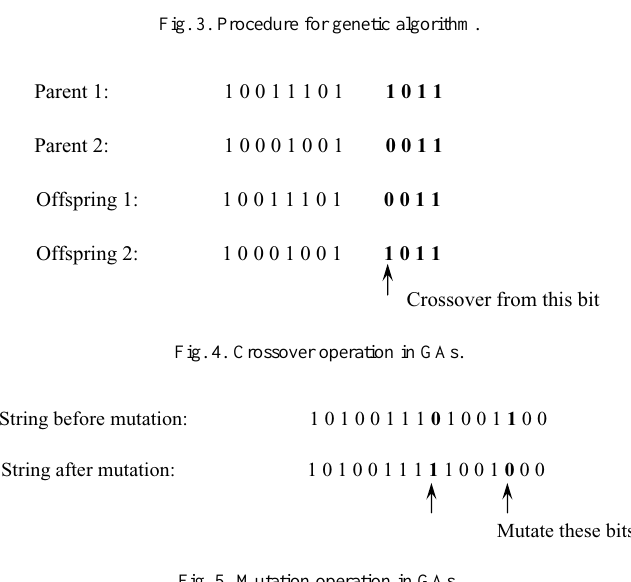
Fig. 5. Mutation operation in